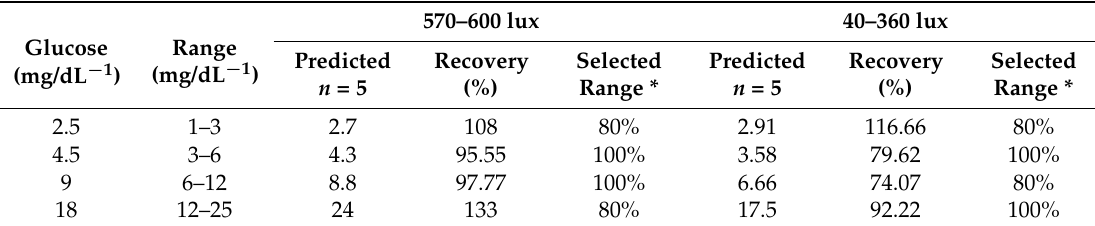
Table 3. Results of the evaluation of color